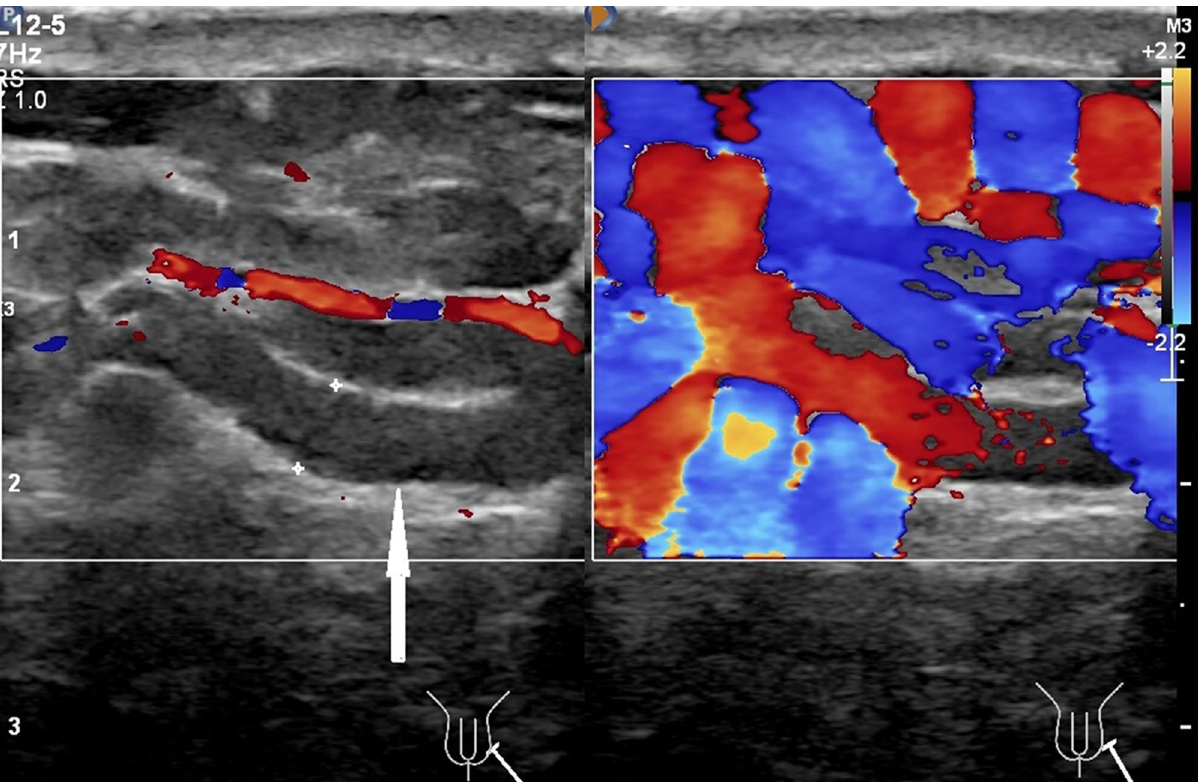
Figure 2. A 34-year-old man with left varicoceles. The veins of left pampiniform plexus present irregular serpiginous fluid-filled anechoic tubular structures (3.2 mm in diameter) in the region of the spermatic cord on gray-scale ultrasound at standing position (left panel, arrow); the fluid-filled anechoic tubular structures show color Doppler flow signal on duplex ultrasound (right